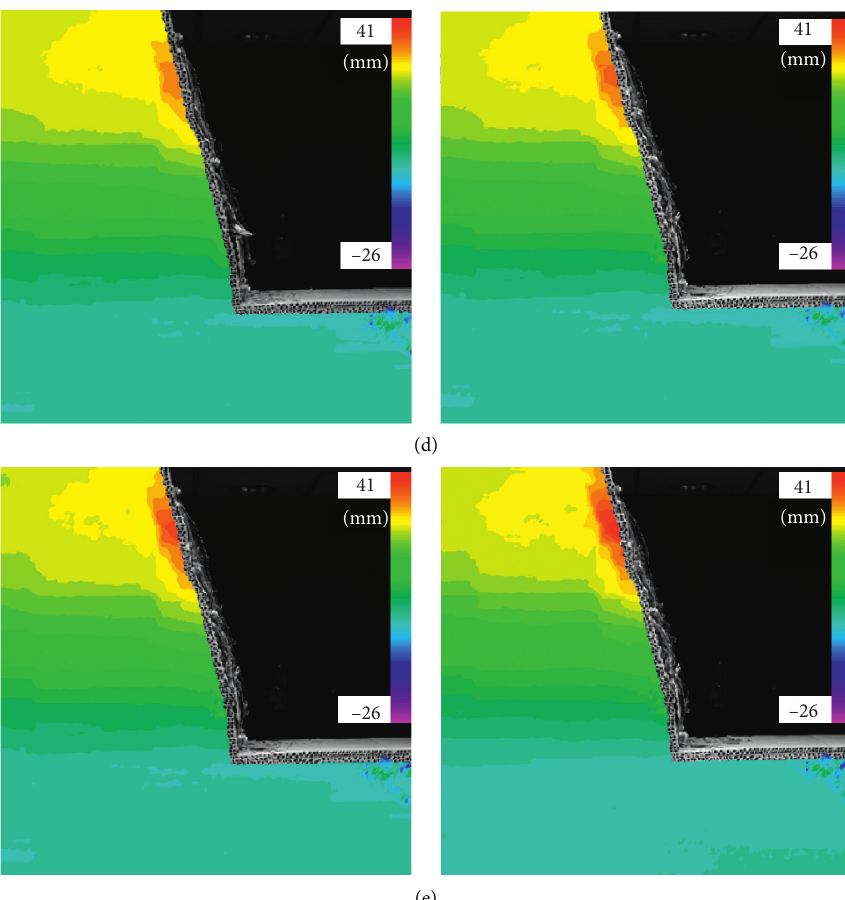
Figure 16: Displacement nephogram of slope model: (a) compaction stage: (i) prior to load application and (ii) after loading; (b) fracture generation stage: (i) prior to load application and (ii) after loading; (c) fracture propagation stage: (i) prior to load application and (ii) after loading; (d) local collapse stage: (i) prior to load application and (ii) after loading; (e) entire collapse stage: (i) prior to load application and (ii) after